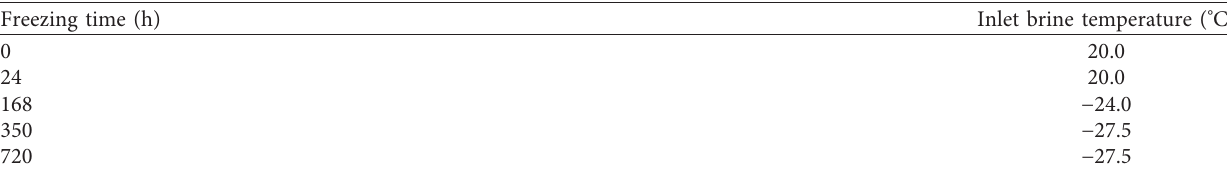
Table 1: Brine cooling plan.